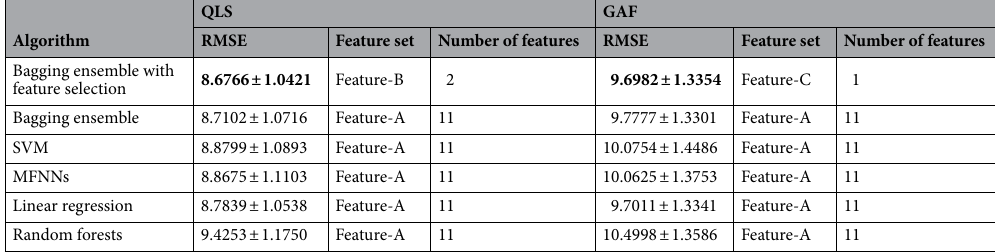
Table 2. The results of repeated tenfold cross-validation experiments for predicting the QLS and GAF functional outcome of schizophrenia with genetic variants using machine learning predictors such as the bagging ensemble model with feature selection, the bagging ensemble model, MFNNs, SVM, linear regression, and random forests. The best QLS or GAF score is shown in bold. Feature-A: 11 features (related to 11 SNPs) including AKT1 rs1130233, COMT rs4680, DISC1 rs821616, DRD3 rs6280, G72 rs1421292, G72 rs2391191, 5-HT2A rs6311, MET rs2237717, MET rs41735, MET rs42336, and TPH2 rs4570625. Feature-B: 2 features (related to 2 SNPs) including G72 rs2391191 and MET rs2237717. Feature-C: 1 feature (related to 1 SNP) including AKT1 rs1130233. GAF Global assessment of functioning, MFNNs Multilayer feedforward